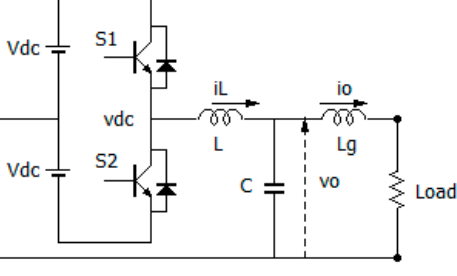
Figure 4. Stand-alone inverter circuit.